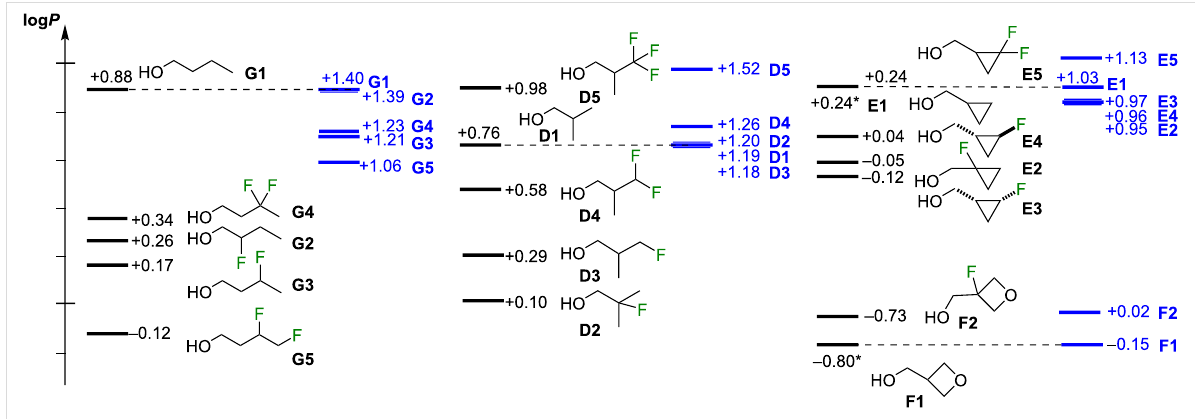
Figure 9: Experimental and theoretical (in blue) values (calculated at the MN15/aug-cc-pVTZ//MN15/cc-pVTZ level of theory). Values for G1 , G4 , G7 , G8 taken from the literature [28]. The distance between the lines relate to the relative lipophilicity differences. Experimental and theoretical data sets normalized towards the parent